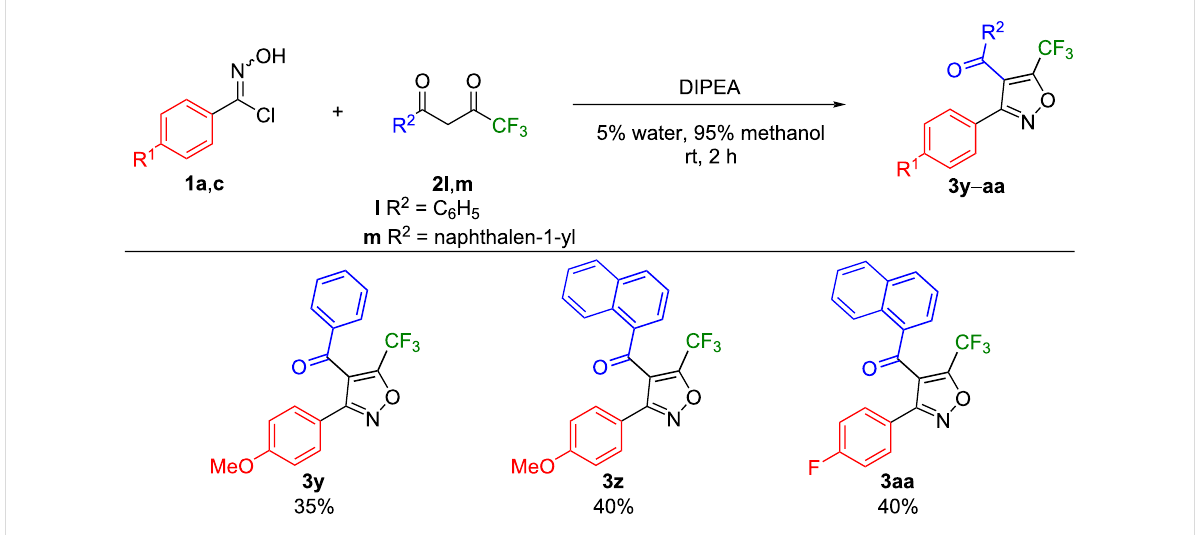
Figure 6: Reactions between phenyl hydroximoyl chlorides 1a , c and 4,4,4-trifluoro-1-phenyl- ( 2l ) and 4,4,4-trifluoro-1-naphthylbutane-1,3-dione ( 2m ) to synthesize trifluoromethyl-substituted isoxazoles 3y – aa .